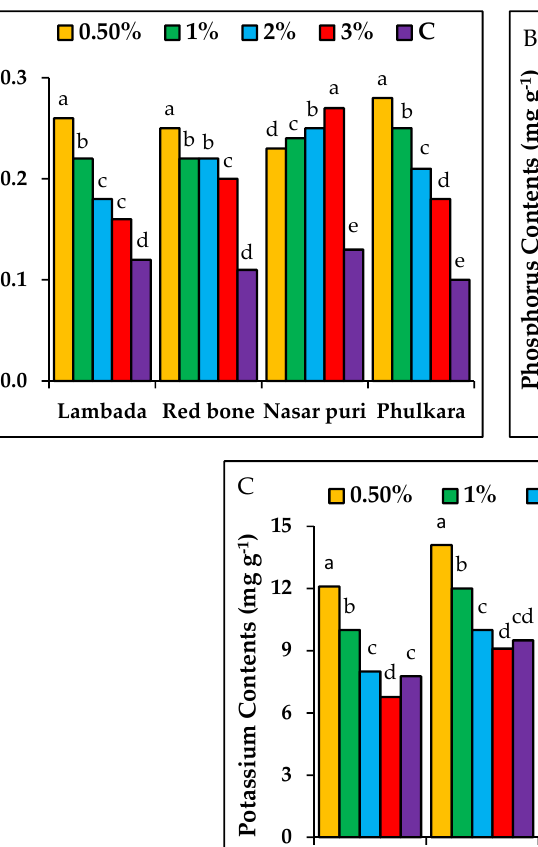
Figure 7. Total soluble solids ( A ) and ascorbic acid ( B ) in onion cultivars as affected by foliar application of 0 (C = control), 0.5, 1, 2, or 3% seaweed extract. Values are means of nine replicates ± standard error. Means with different letters are significantly different from each other compared by LSD at p ≤ 0.05.